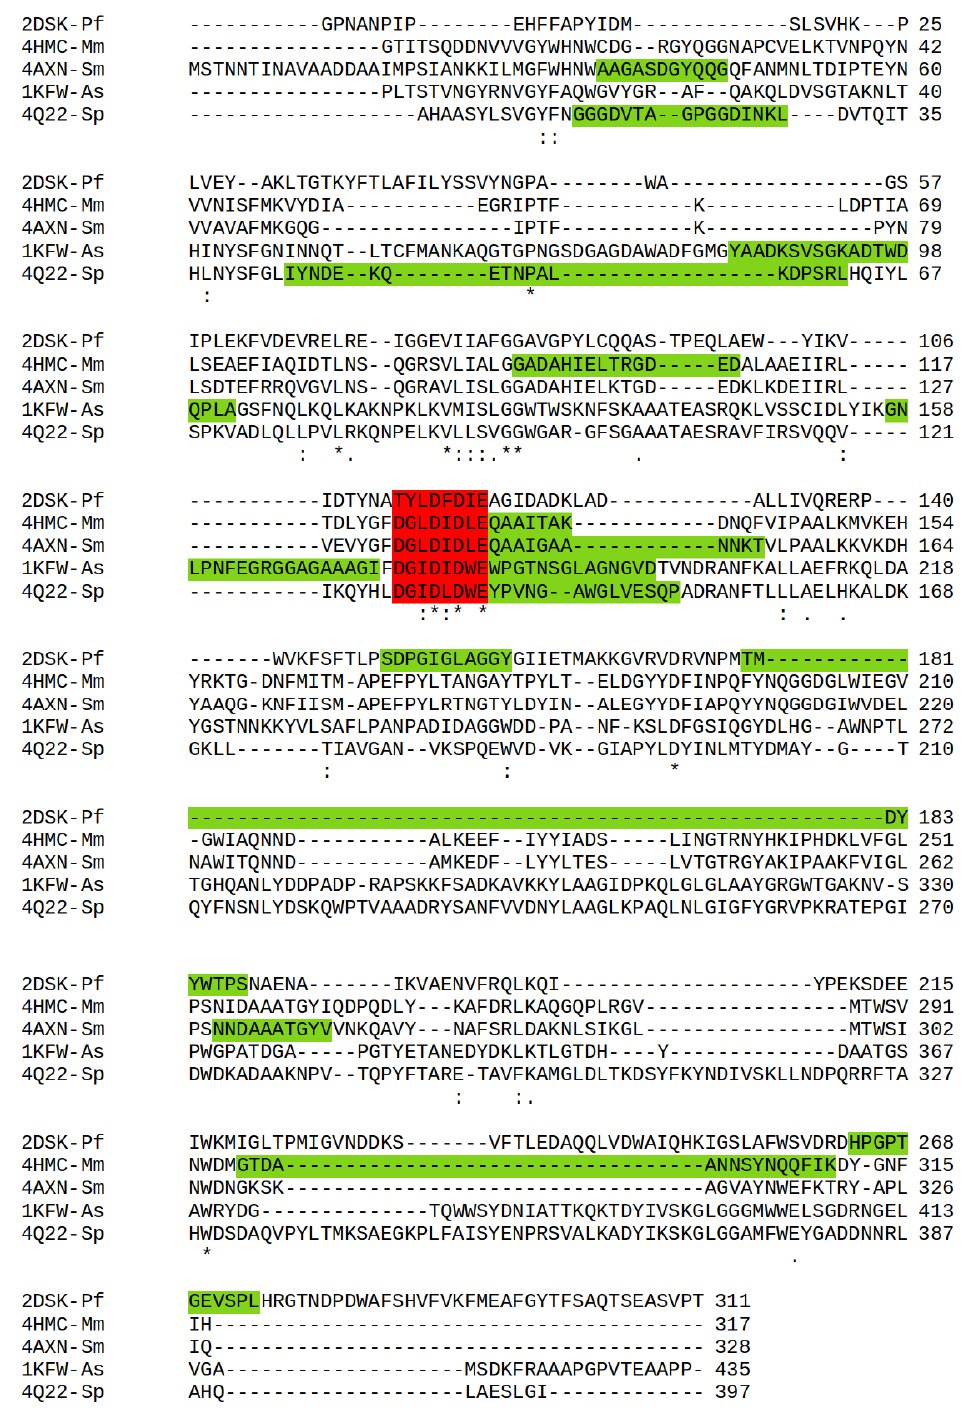
Figure 6. Multiple alignments of thermally adapted chitinases. Active-site residues (stars) within active sites (red) and loops (green). (*), Fully conserved residue; (:), conservation between groups of strongly similar properties; (.), conservation between groups of weakly similar properties.